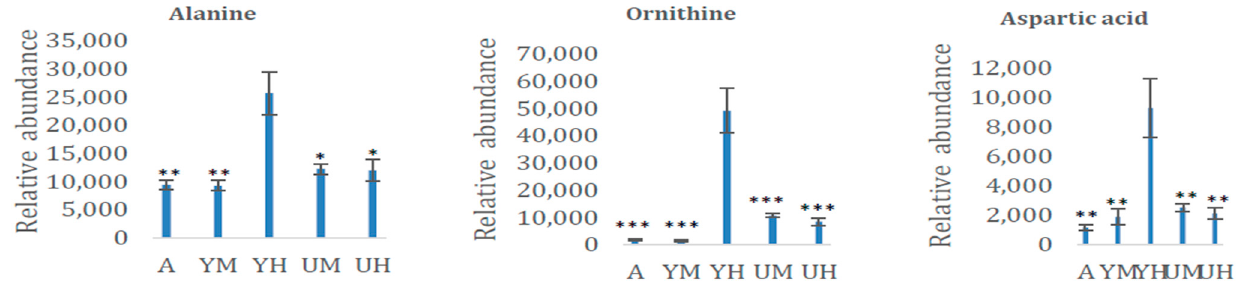
Figure 2. Relative contents (means ± standard deviations, n = 8) of three amino acids in the Chlorella cultures after 8 days of cultivation in the following growth conditions: autotrophic (AUTO), mixotrophic with glycerol (GLY MIXO), heterotrophic with glycerol (GLY HETE), mixotrophic with glucose (GLU MIXO), heterotrophic with glucose (GLU HETE). *, **, and *** indicate significant differences in concentration relative to cultures grown in heterotrophic conditions with glycerol according to Student’s t -test at p < 0.05, 0.01, and 0.001, respectively.